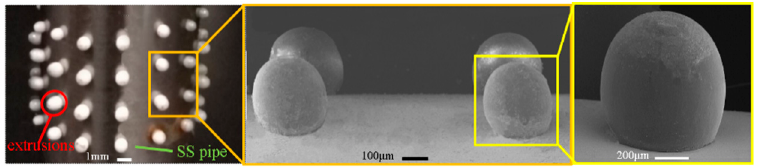
Figure 10. Electroforming mandrel with spherical extrusion polymer patterns.